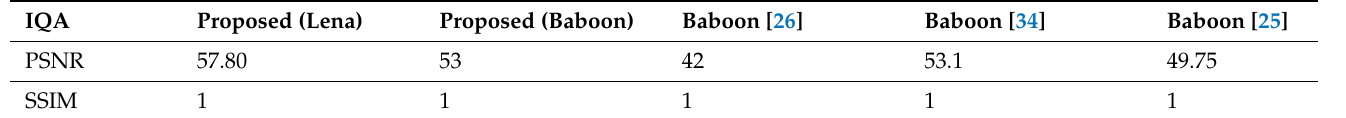
Table 6. Impercepability analysis.